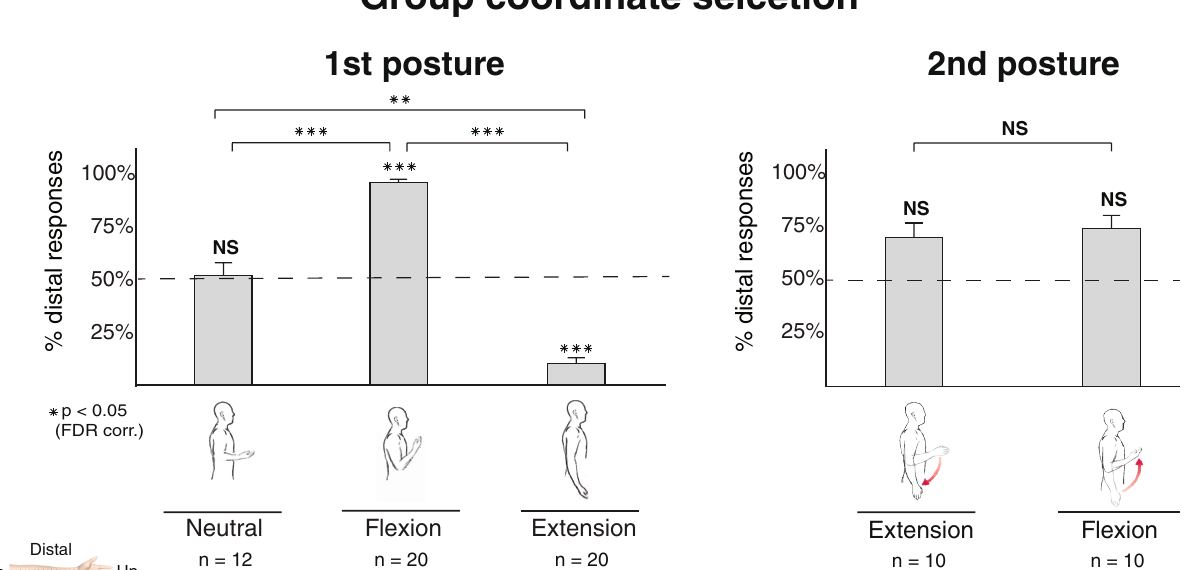
Figure 2. Group results on coordinate selection for parts one and two. We calculated the average proportion of responses fitting a distal mapping to the upper part of the image by posture and compared each one to chance (bars indicate the standard error; dashed line indicates chance level). In part one, the average distal proportion was above chance in the Flexion group, below chance in the Extension condition (i.e., a proximal preference), and insignificant in the Neutral condition. The differences in responses show the implicit effect of posture on coordinate selection. After switching postures in part two, average distal responses in the Flexion and Extension conditions were not different from